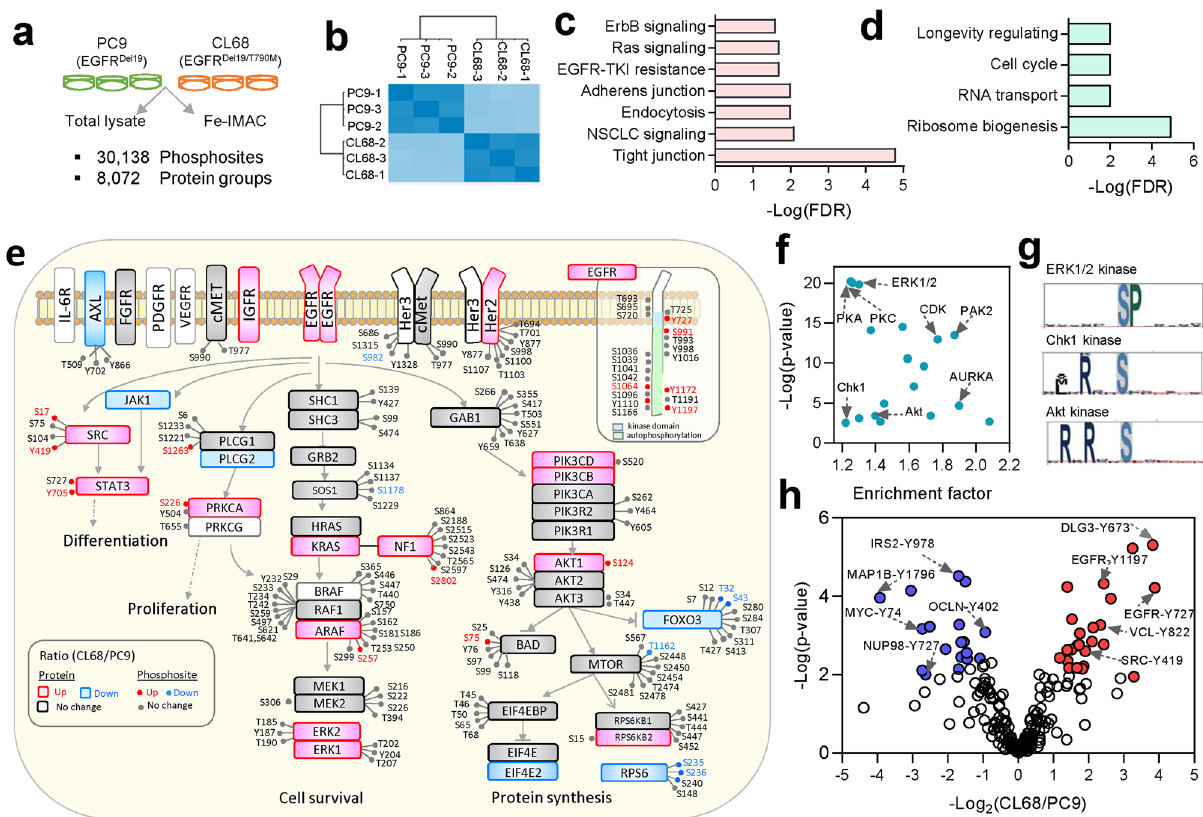
Fig. 5 Differential phosphoproteome pro fi ling of EGFR-TKI-sensitive and resistant lung cancer cells. a Experimental design and summary of the identi fi cation and quanti fi cation results of the proteome and phosphoproteome in EGFR-TKI-sensitive (PC9) and EGFR-TKI-resistant (CL68) lung cancer cells in three biological triplicates. b Pearson ’ s correlation of phosphosite abundance in biological triplicate analysis. KEGG signaling pathways enriched ( p < 0.05) from c upregulated and d downregulated phosphosites/phosphoproteins using STRING (two-sampled t -test, FDR < 0.01, S0 = 0.1). e Overall, 161 phosphosites and 49 proteins were quanti fi ed in the EGFR-TKI resistance signaling pathway, revealing differentially expressed proteins (two-sampled t -test, FDR < 0.01, S0 = 0.4) and phosphosites (two-sampled t -test, FDR< 0.01, S0 = 0.1). f Kinase mot fi enrichment analysis using Fisher ’ s exact test (FDR < 0.02) where top ones shown among 30 kinase motifs. g Motif logo for ERK1, 2, and PKA or PKC kinases extracted by pLOGO (https://plogo.uconn.edu/). h Tyrosine phosphosites showing differential expression levels between the two cell lines (two-sampled t -test, FDR < 0.01, S0 = 0.1). Source data are provided as a Source Data fi